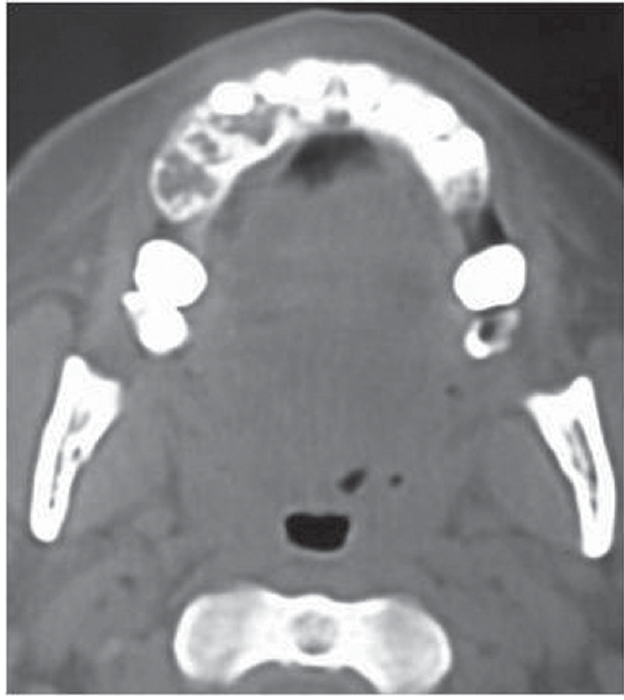
Fig. 3 . Axial CT scan showing that the lesion extending on the buccal and palatal aspects from the right lateral incisor to right second molar. Incisional biopsy was performed and the histopathologic evaluation of the specimen (Figure 4) showed irregular, bizarrely shaped odontogenic epithelial islands and cords in a moderately cellular fibrous connective tissue with abundant thick collagen fibers that appear to compress the odontogenic islands giving them a stellate or an “animal- like” configuration and the diagnosis of desmoplastic ameloblastoma was established. Excision of the lesion with extraction of right lateral incisor and right canine was done, followed by reconstruction of the defect with buccal pad of fat and primary mucosal